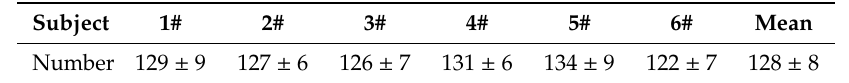
Table 1. The average sampling numbers contained in a gait cycle (GC) of di ff erent